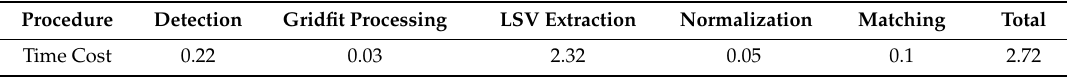
Table 6. The computational time cost of the proposed